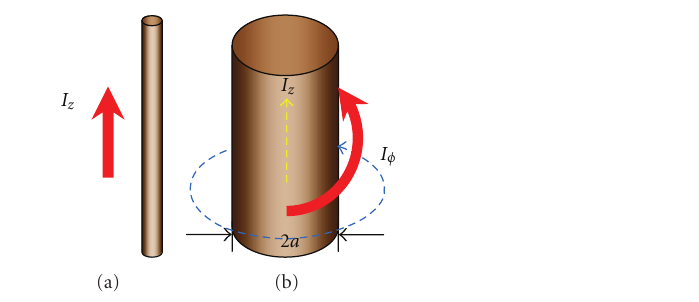
Figure 4: (a) Ideal analytical line form current; (b) Actual situations of current distribution on a cylindrical extended conductor.